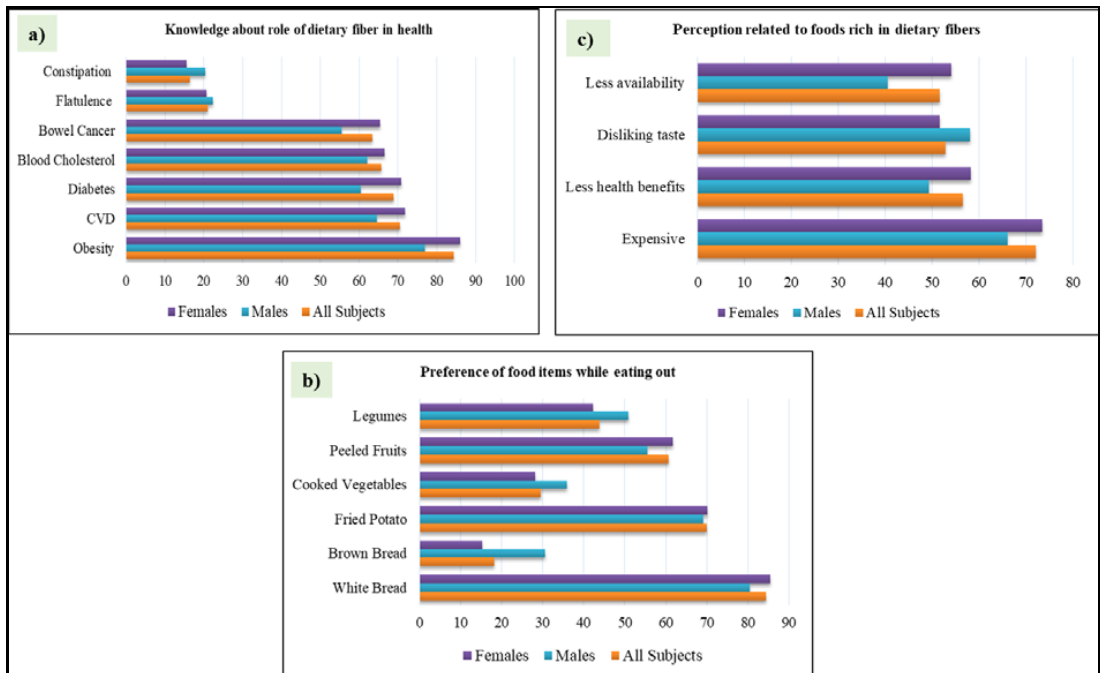
Figure 1. Knowledge ( a ), preferences ( b ) and perception ( c ) of study participants regarding foods rich in DF. Note: Data are presented in bar-graphs showing percentages of all participants, males alone and females alone.